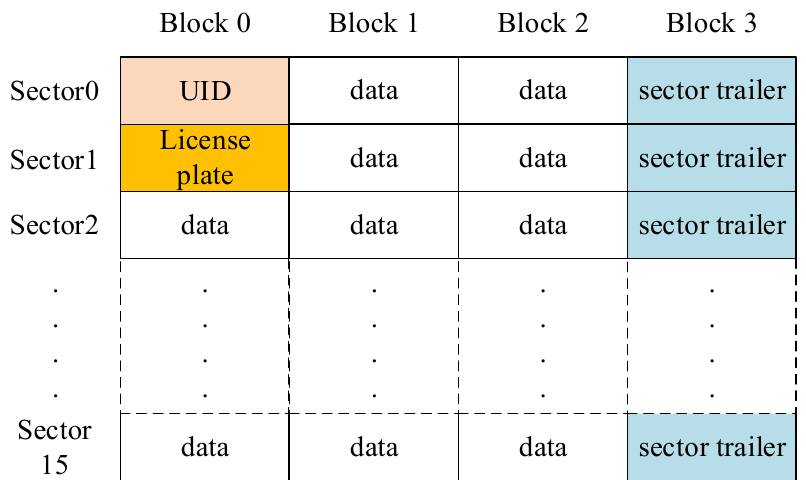
Figure 10. Architecture diagram of the key cabinet communication system.